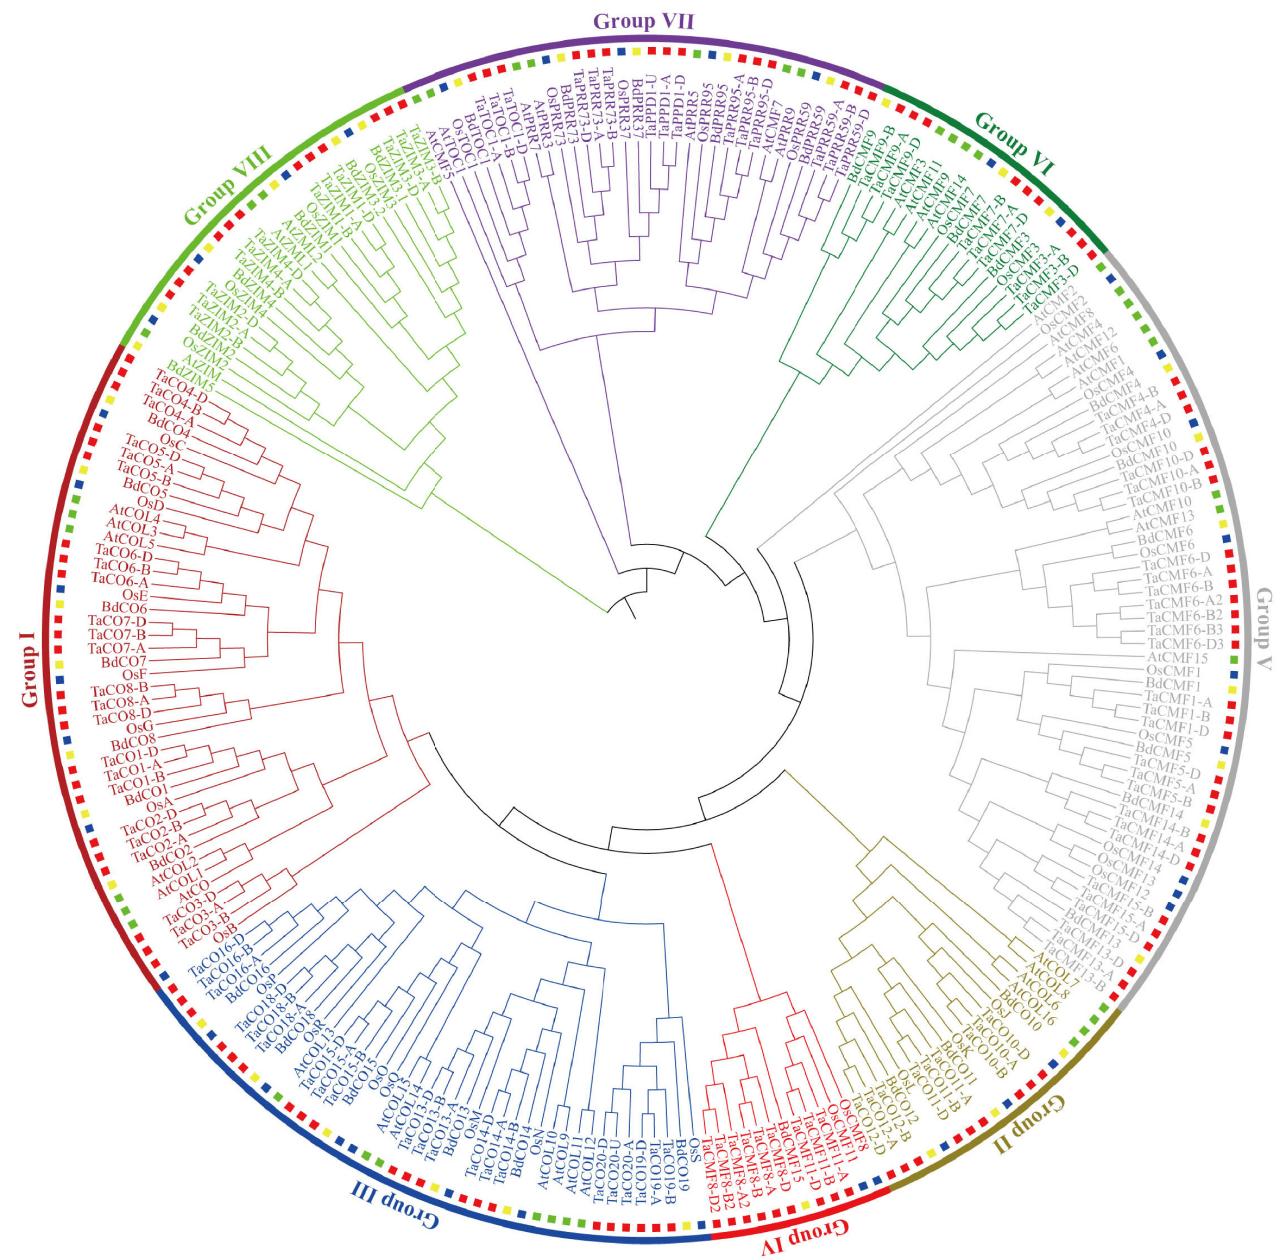
Fig 1. Phylogenetic analysis of CCT proteins in wheat, Arabidopsis , Brachypodium , and rice. The CCT proteins were phylogenetically analyzed using MEGA v6.0 following the UPGMA method. The proteins from different plants are represented in different colored squares (wheat, red; Arabidopsis , green; Brachypodium , yellow; rice, blue). The gene IDs are listed in S1 and S2 Tables. domains were consistent with that based on phylogeny (Fig 2). Most of the CCT domains (cor- responding to motif 1) were predicted to be located at the C-terminal of the protein, but TaCO13-B lacked this domain due to a premature transcriptional termination within the penultimate exon. ZIM proteins (Group VIII) were predicted to possess their CCT domains in the middle, with the extra tify domain (corresponding to motif 5) at the N-terminal and the